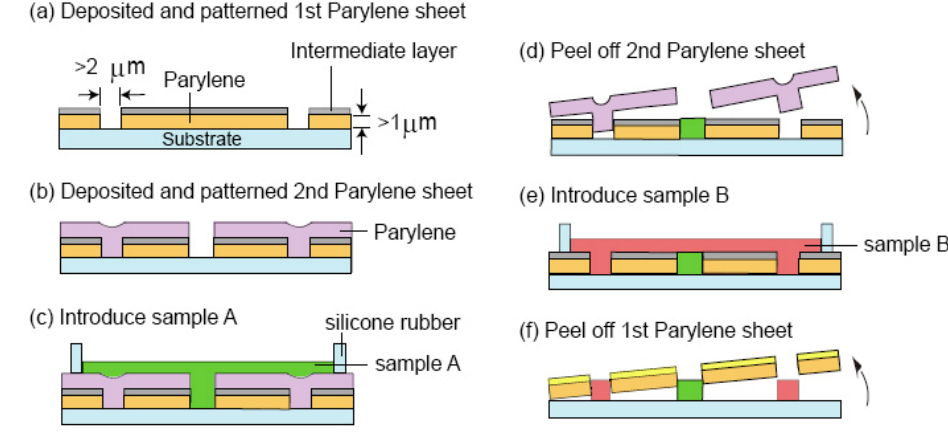
Figure 12. Process flow showing the selective patterning of two types of biomolecular samples using sequential multilayer parylene lift-off steps. Reprinted with permission from reference [50]. Copyright (2007)